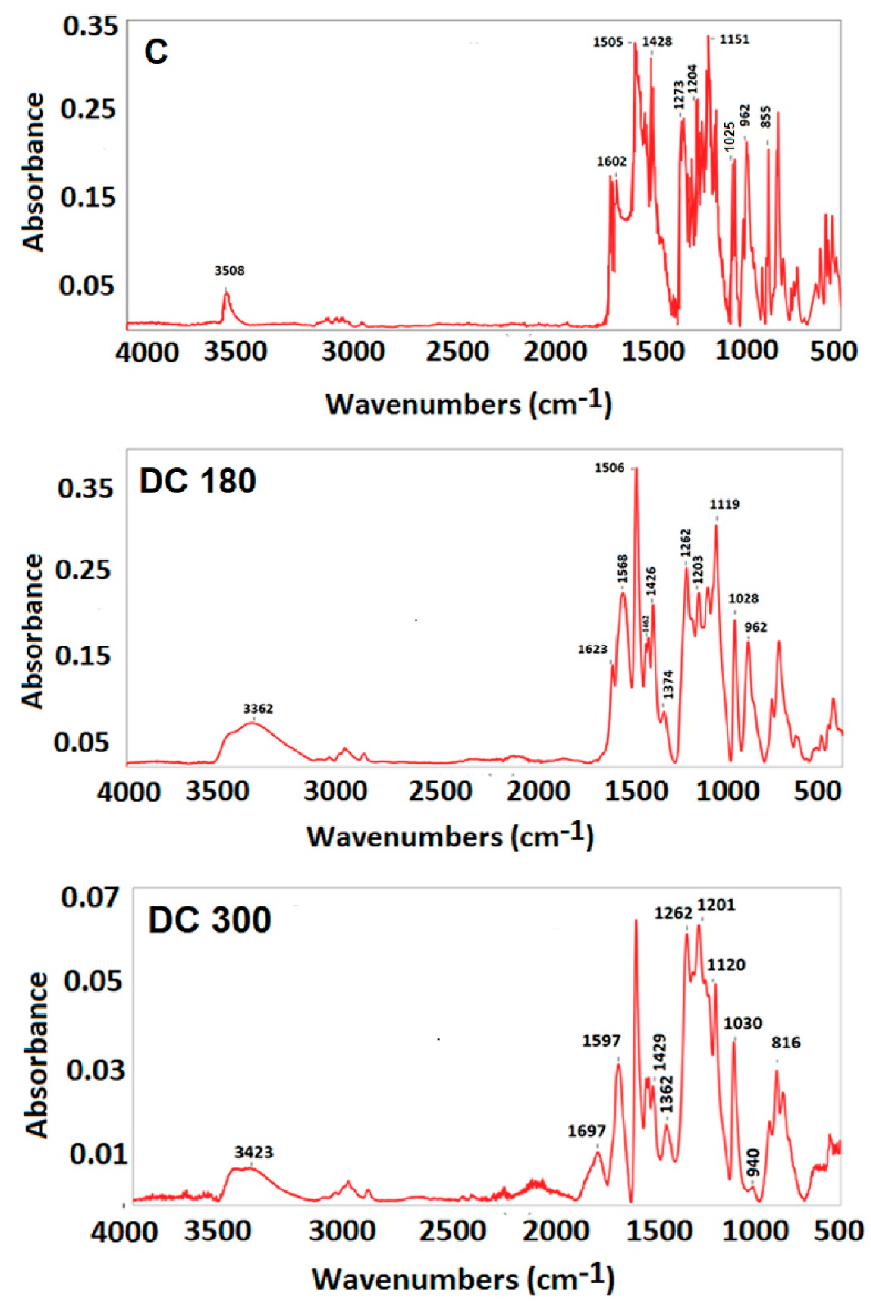
Figure 3. The FT-IR spectrum of untreated curcumin powder (C) and of curcumin degraded at 180 °C (DC 180) or at 300 °C (DC 300).